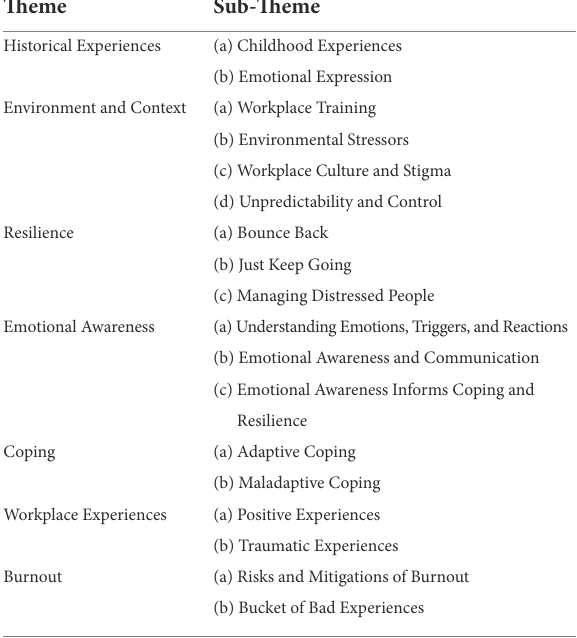
TABLE 3 Naming convention for themes and